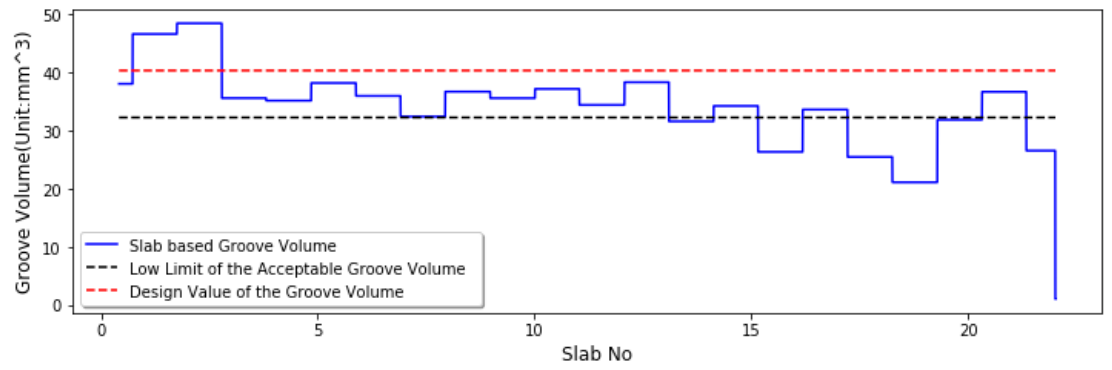
Figure 15. Plot of the groove volume distribution along runway test.